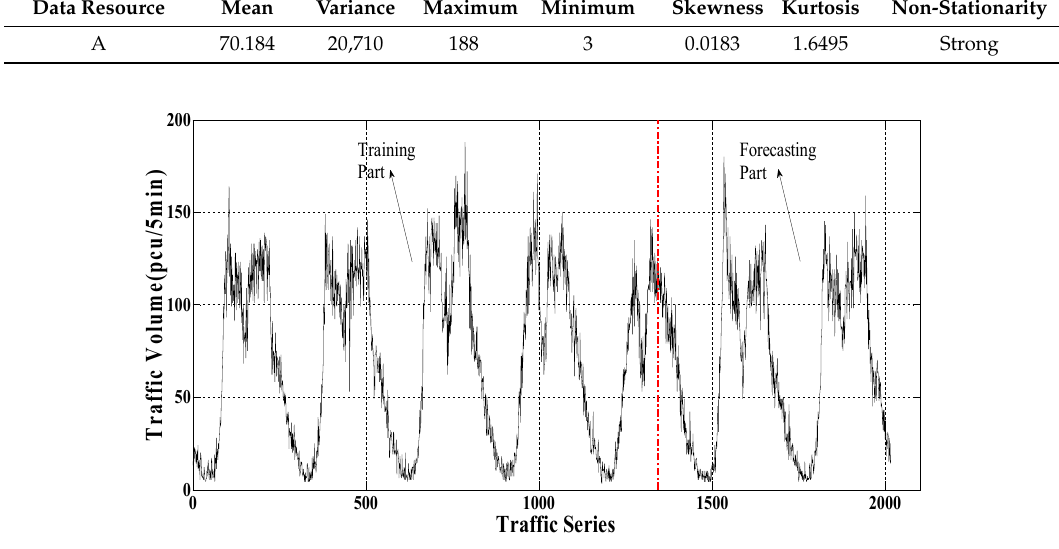
Figure 3. Traffic volume time series (A).